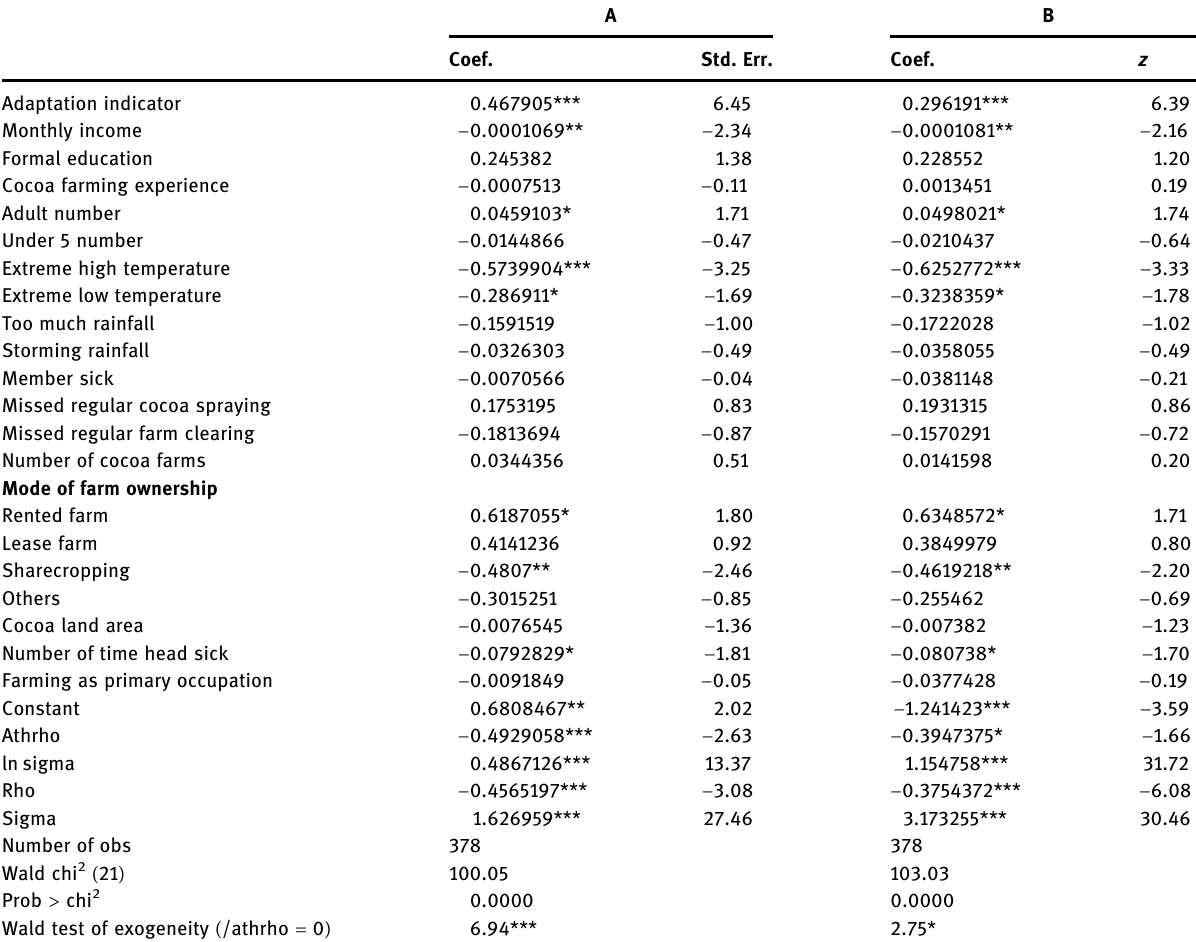
Table 6: Determinants of farmers ’ decision to rehabilitate cocoa